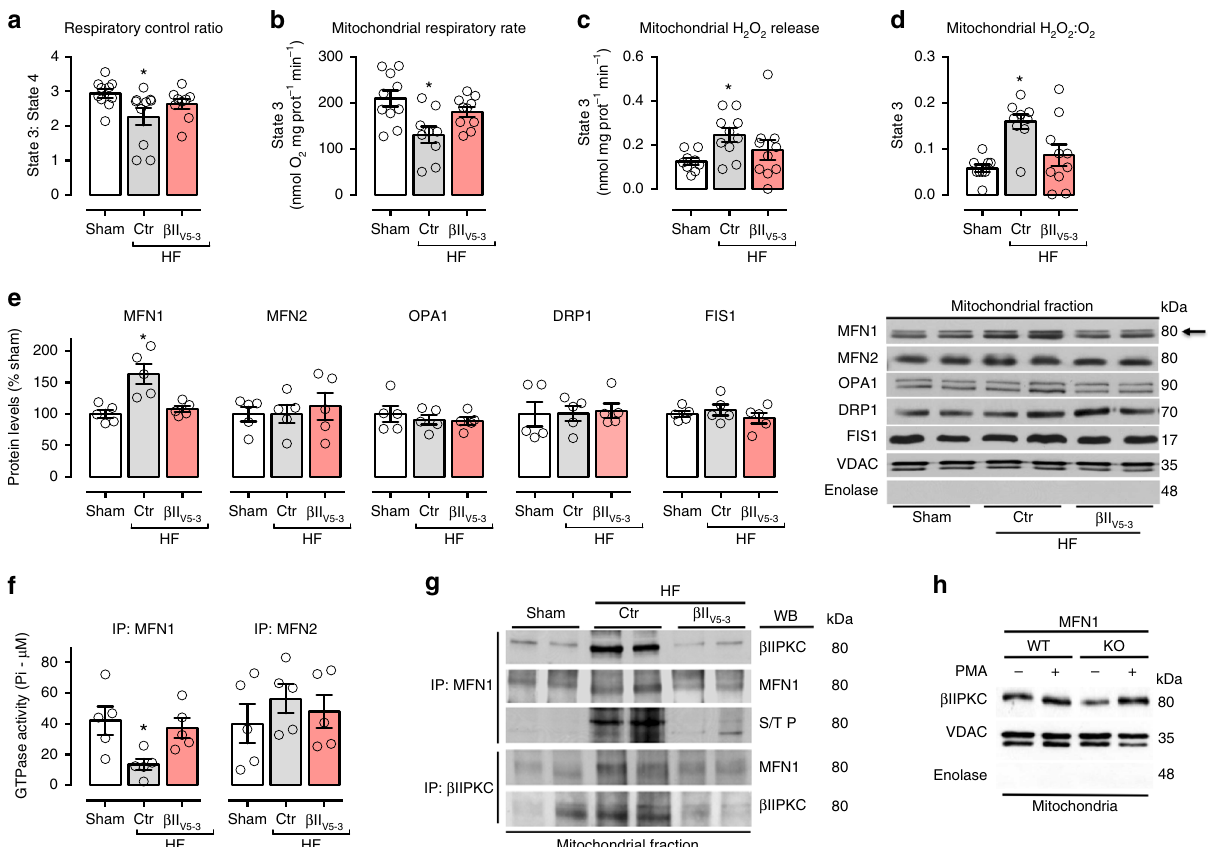
Fig. 3 β IIPKC inhibition improves bioenergetics in failing hearts. a Mitochondrial respiratory control ratio, b State 3-dependent oxygen control rate, c absolute H 2 O 2 release and d H 2 O : O 2 in heart samples from sham (white bars, n = 10), TAT-treated heart failure (HF-Ctr, gray bars, n = 10) and β II V5-3 - treated heart failure (HF- β II V5-3 , red bars, n = 10). e Mfn1, Mfn2, Opa1, Drp1, and Fis1 protein levels and representative western blots; and f Mfn1 and Mfn2 GTPase activity in cardiac mitochondrial fraction ( n = 5 per group) from sham, HF-Ctr and HF- β II V5-3 . g Cardiac mitochondrial Mfn1 and β IIPKC immunoprecipitate probed against anti- β IIPKC, Mfn1 and phosphorylated serine/threonine antibodies (representative blot of three independent experiments) from sham, HF-Ctr and HF- β II V5-3 groups. Biochemical measurements were performed in the cardiac remote (viable) zone. These measurements were performed at the end of the experimental protocol. h Mfn1 wild type (WT, n = 5) and knockout (KO, n = 5) MEFs were treated with PMA [10 nM phorbol ester 12-myristate 13-acetate, for 30 min, an activator of most PKC isozymes 11 ] and accumulation of mitochondrial β IIPKC was analyzed by western blot (representative blots of three independent experiments). Data are means ± SEM. * P < 0.05 vs. Sham rats. One-way analysis of variance (ANOVA) with post-hoc testing by